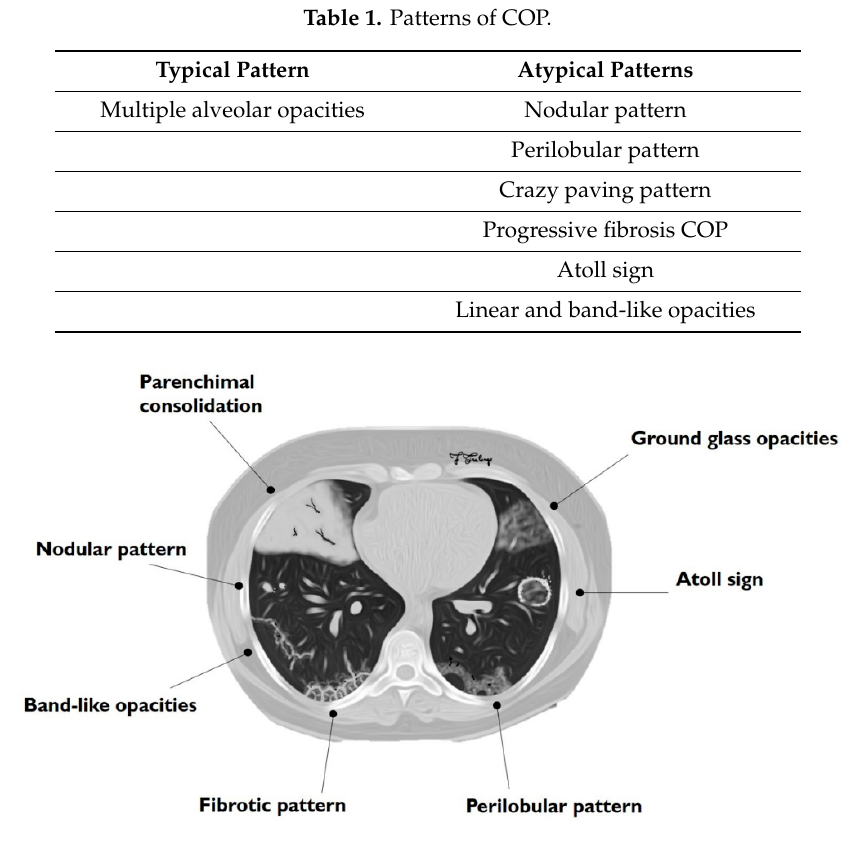
Figure 1. Schematic drawing of main imaging patterns of cryptogenic organizing pneumonia (COP). Table 1 . Patterns of COP.